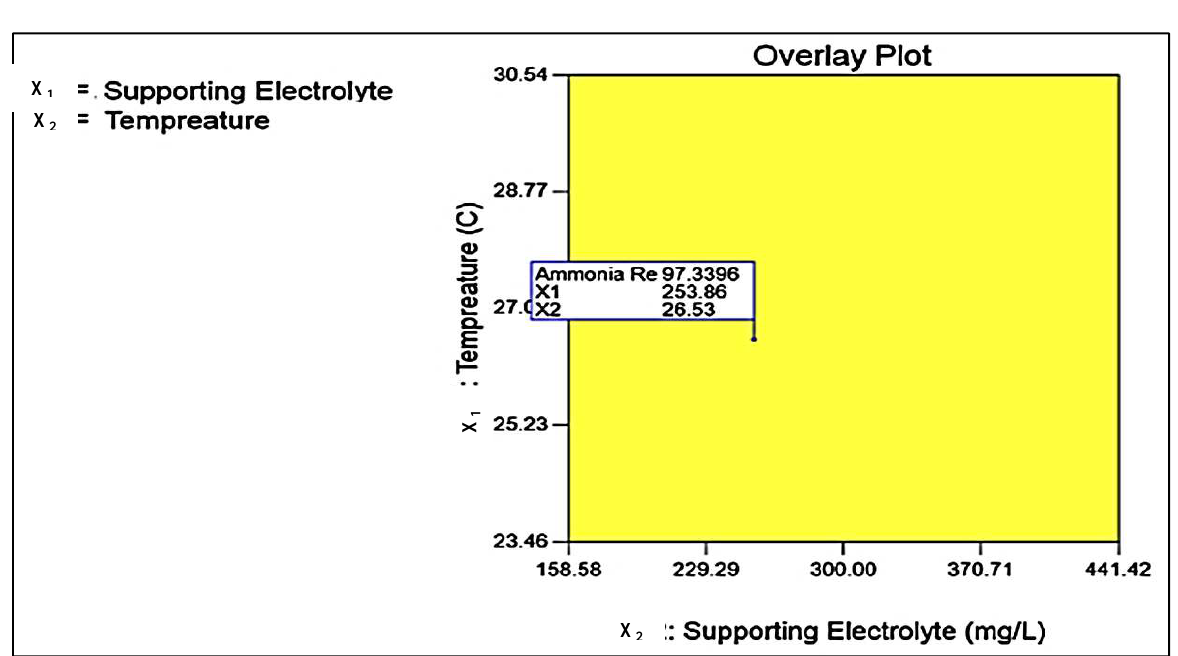
Figure 6. Overlay plot for ammonium removal Table 4. Optimum condition verification and additional experiments Response